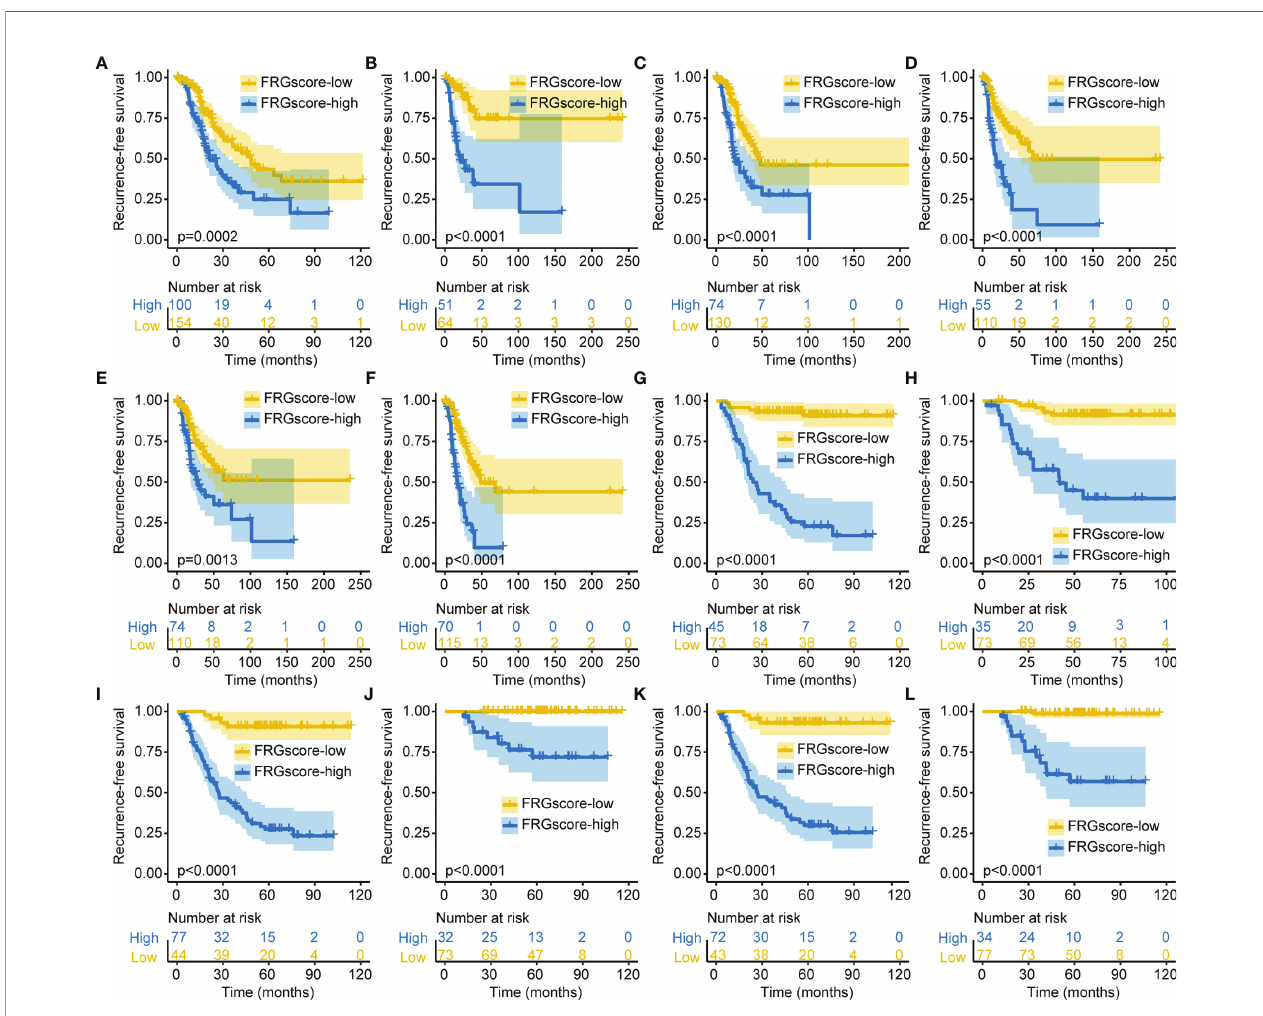
FIGURE 4 | Validation of FRGscore in different clinical subgroups. (A – F) Kaplan – Meier curves of recurrence-free survival in older (A) , younger (B) , female (C) , male (D) , non-smoker (E) , and smoker (F) subgroups for early-stage LUAD patients based on FRGscore in TCGA cohort. (G – L) Kaplan – Meier curves of recurrence-free survival in older (G) , younger (H) , female (I) , male (J) , non-smoker (K) , and smoker (L) subgroups for early-stage LUAD patients based on FRGscore in GSE31210 cohort. FRGscore, ferroptosis-related gene score; LUAD, lung adenocarcinoma; TCGA, The Cancer Genome